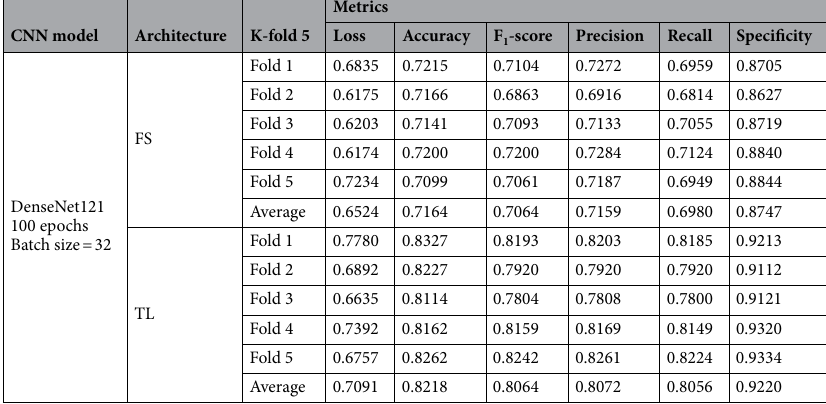
Table 5. Quantified performances of DenseNet121 with FS and TL architectures. FS from scratch, TL transfer learning.